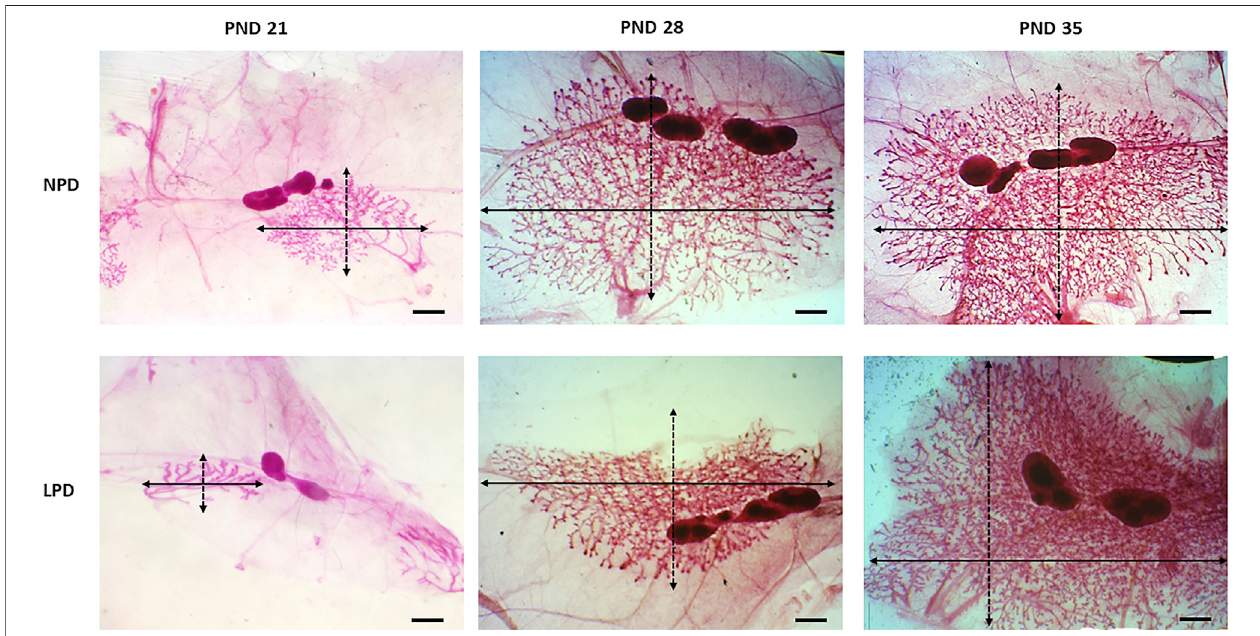
FIGURE2| Representativeimagesofthewhole-mount-stainedmammarygland.Outgrowthmeasurementsineachgroup:transversalgrowth(blackdottedarrow) and ductal elongation (black arrow). LPD, low-protein diet; PND, postnatal day (scale bar (cid:1) 20 µm).